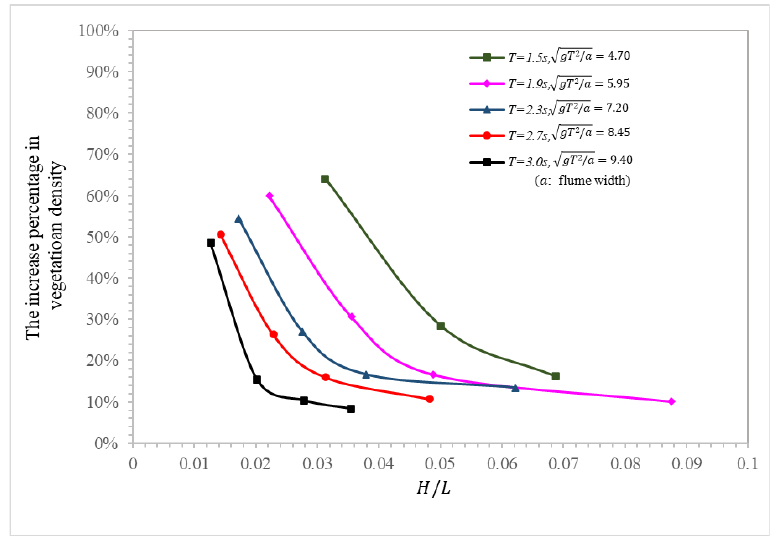
Figure 9. Decrease of wave overtopping with different vegetation densities.